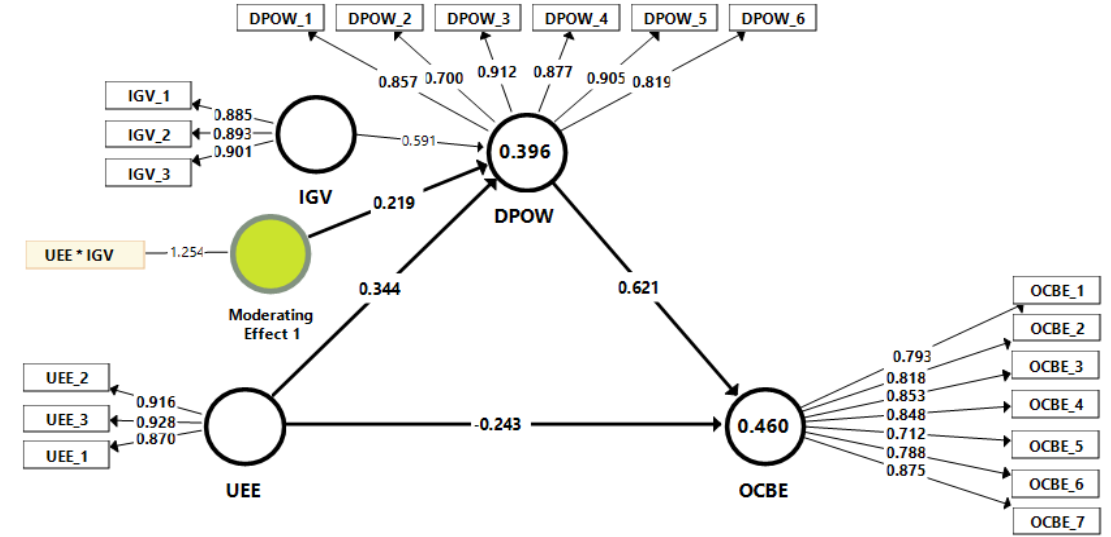
Table 5. The structural model’s results.